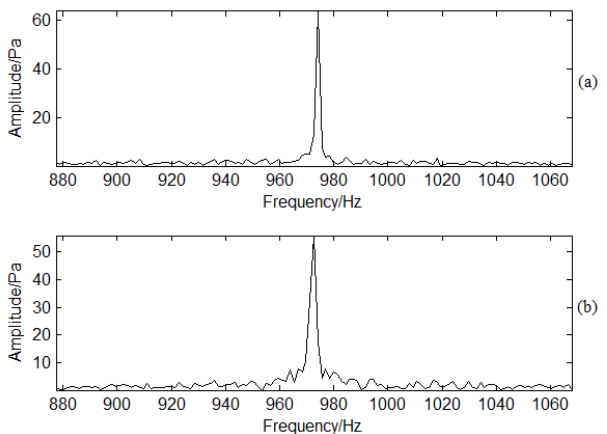
Figure 13. Enlarged frequency domain signal analysis under different working conditions: ( a ) Normal conditions; ( b ) Crack